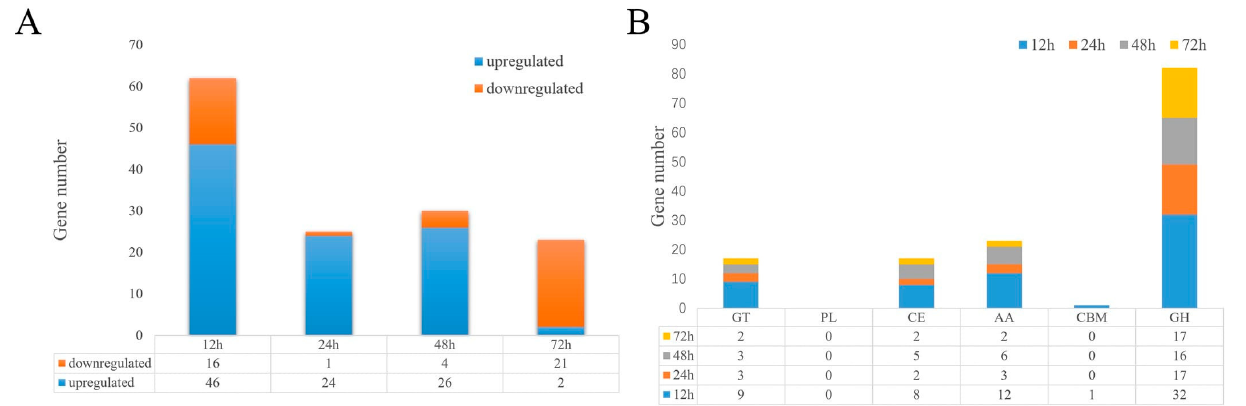
Figure 6. ( A ) Summary of DEGs of CAZymes in T. harzianum T4 grown for 12, 24, 48 and 72 h in the presence of BCCW. ( B ) Summary of upregulated and downregulated DEGs of CAZymes. GH, AA, CBM, CE, GT and PL represent glycoside hydrolase, auxiliary activity, carbohydrate-binding module, carbohydrate esterase, glycosyltransferase and polysaccharide lyase, respectively.